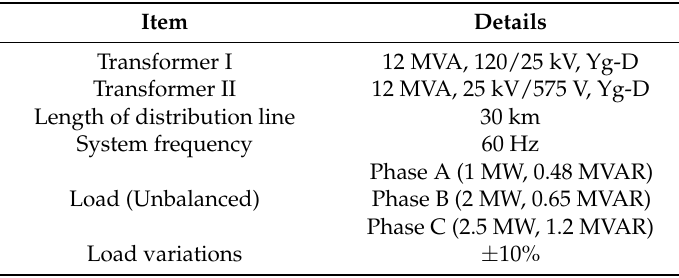
Table 2. Four-node test distribution feeder specifications.